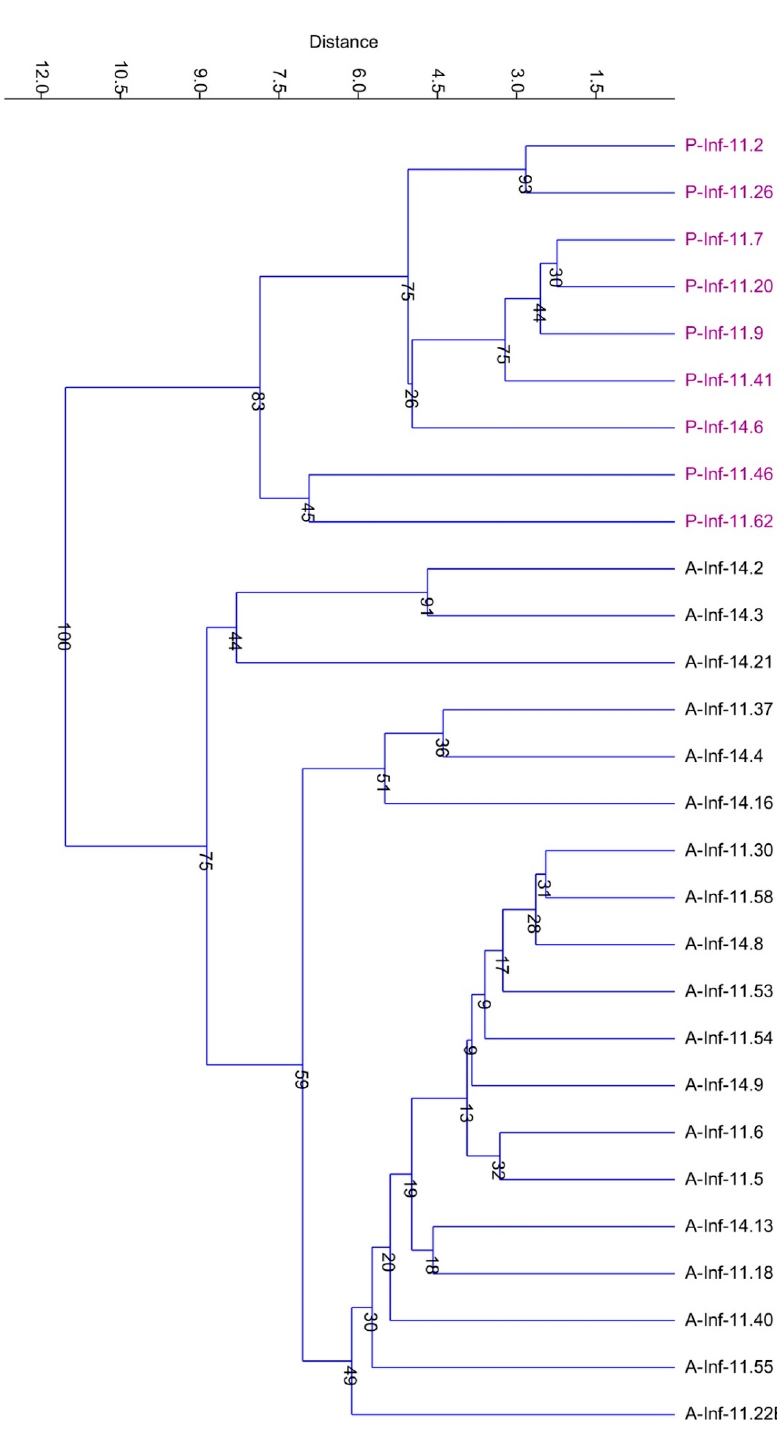
Figure 8. UPGMA analysis (Bray-Curtis distance) performed on the whole antibiotic and heavy metal resistance pattern data matrix. Abbreviations: A and P indicate Acinetobacter and Pseudomonas strains, respectively .